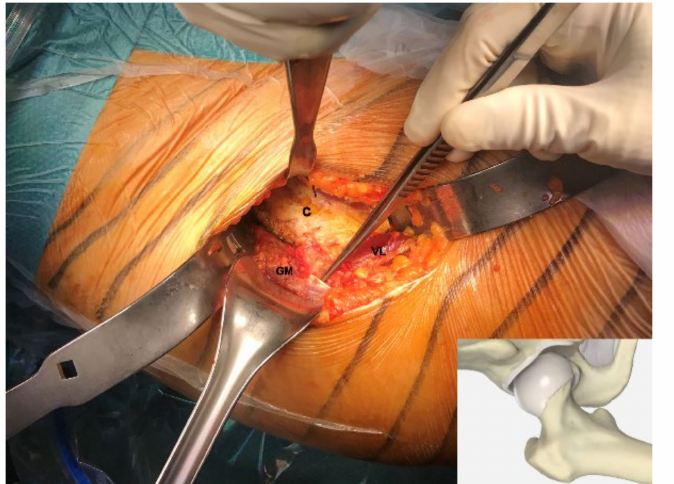
Figure 1. Harvesting a small fragment from the Gluteus Minimus (GM) tendon, indicated by the surgical forceps, during a total hip replacement through an anterior approach. The small fragment is collected at the mid-tendon substance, the white region with the typical structure of the dense regular connective tissue. The hip capsule (C) has been isolated and the Vastus Lateralis (VS) is visible at the bottom of the surgical